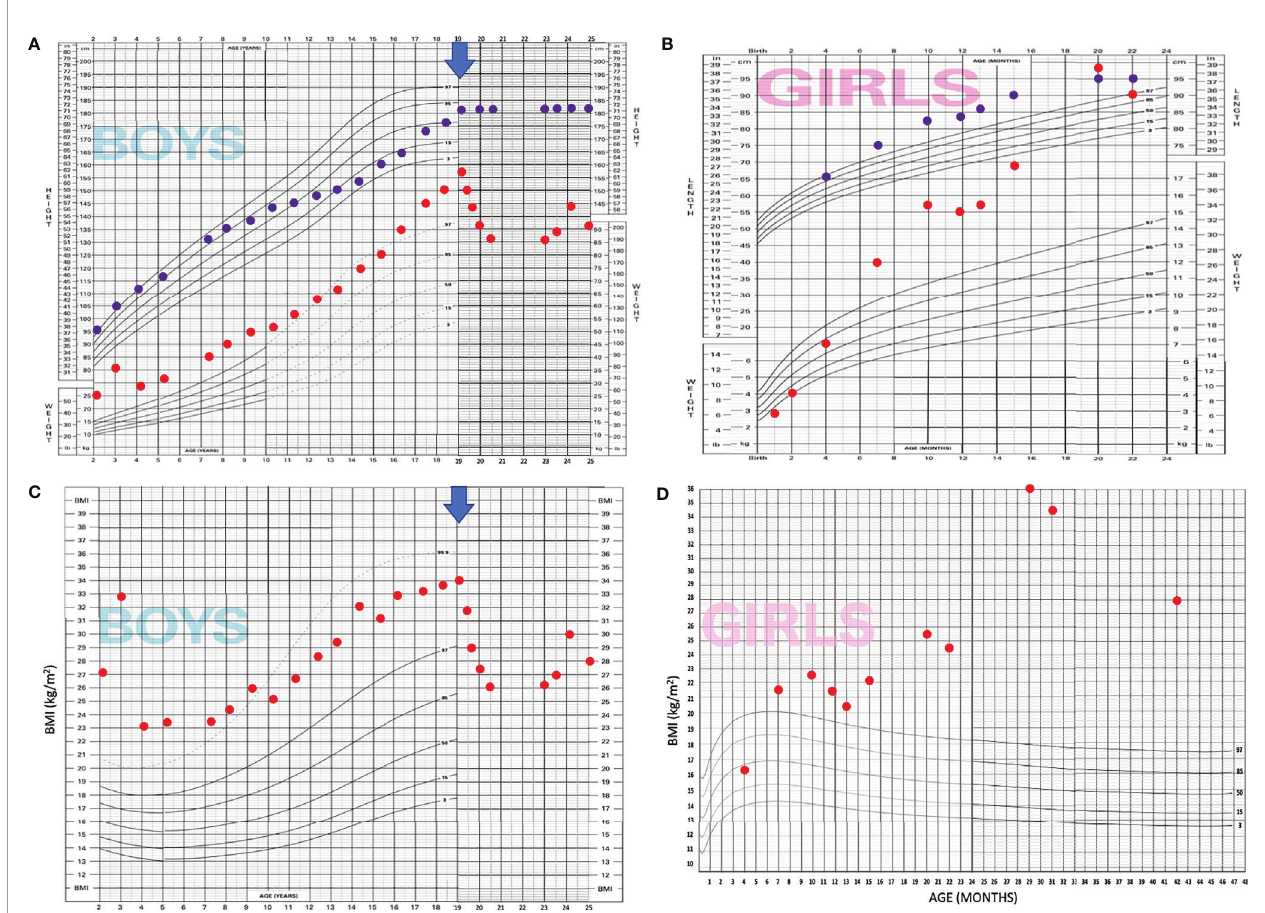
FIGURE 2 | Modi fi ed WHO growth charts* display both case patients. (A) Case patient 1 — length for age and weight for age; (B) : Case patient 1 — BMI for age, (C) : Case patient 2 — length for age and weight for age, (D) : Case patient 2 — BMI for age; BLUE ARROW marks the onset of setmelanotide treatment of case patient 1. *Original WHO growth charts were modi fi ed due to restrictions of scale and